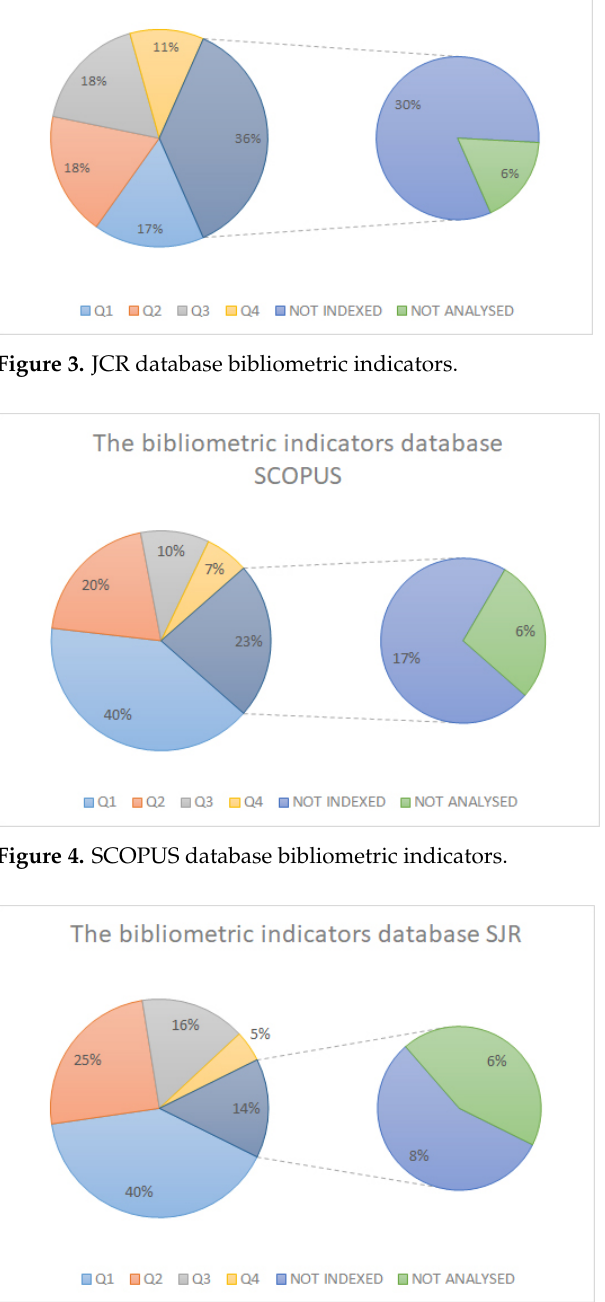
Figure 5. SJR database bibliometric